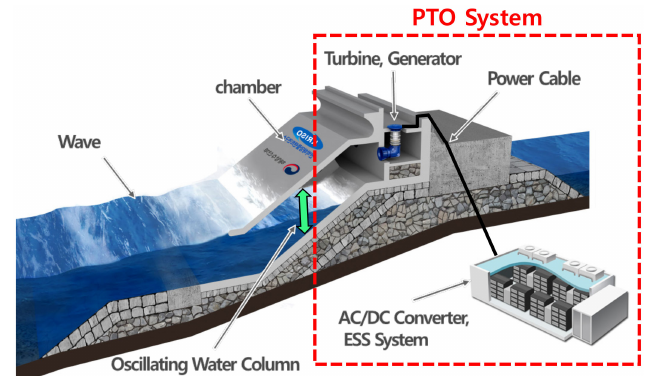
Figure 1. Model of the oscillating water column